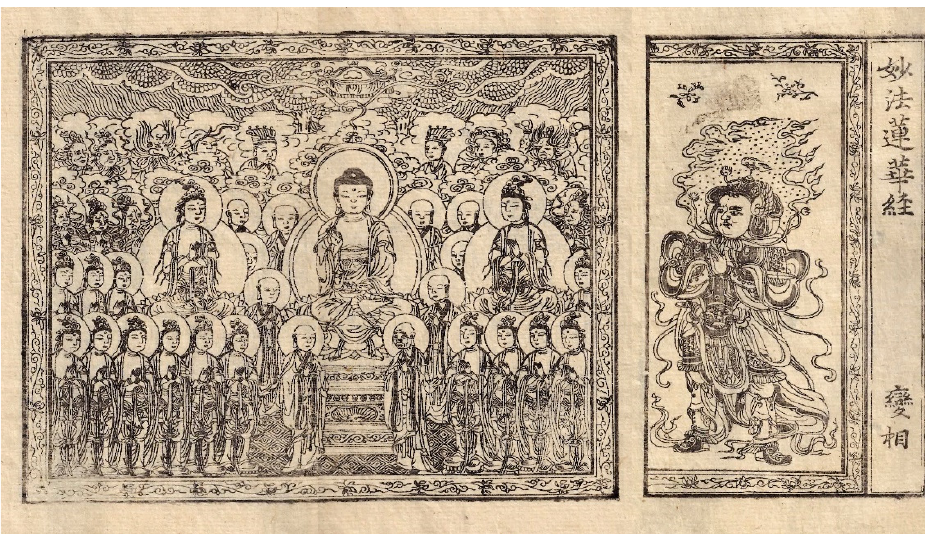
Figure 9. Lotus Sutra, Joseon dynasty (1422), 21.0 × 13.5 cm, private collection (Photo by the author).